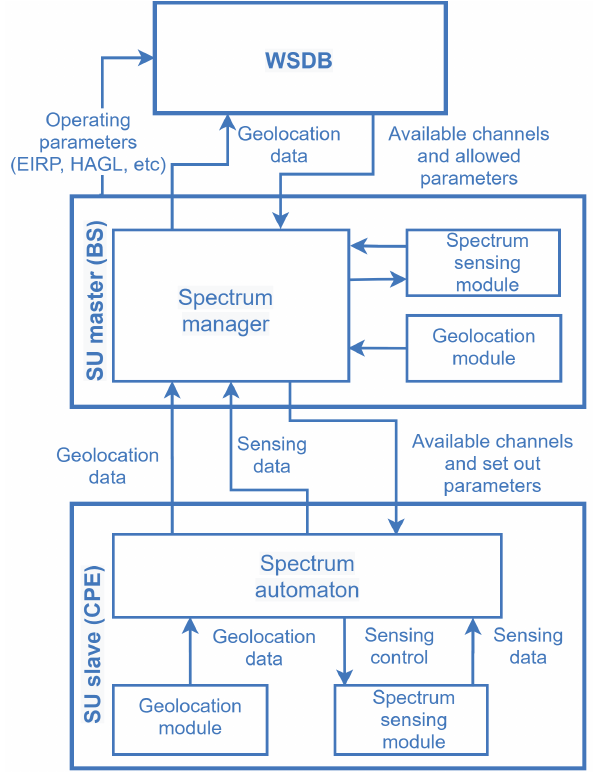
Figure 4. Entity relationship to coordinate spectrum sharing based on WSDB and spectrum sensing, according to the IEEE 802.22